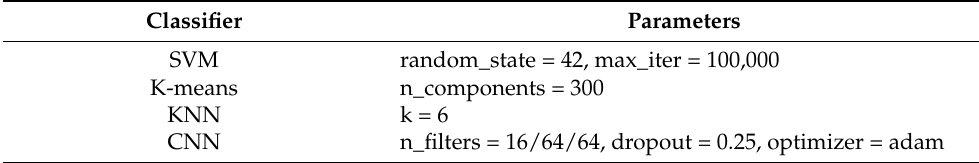
Table 3. Parameters of the AD algorithms.